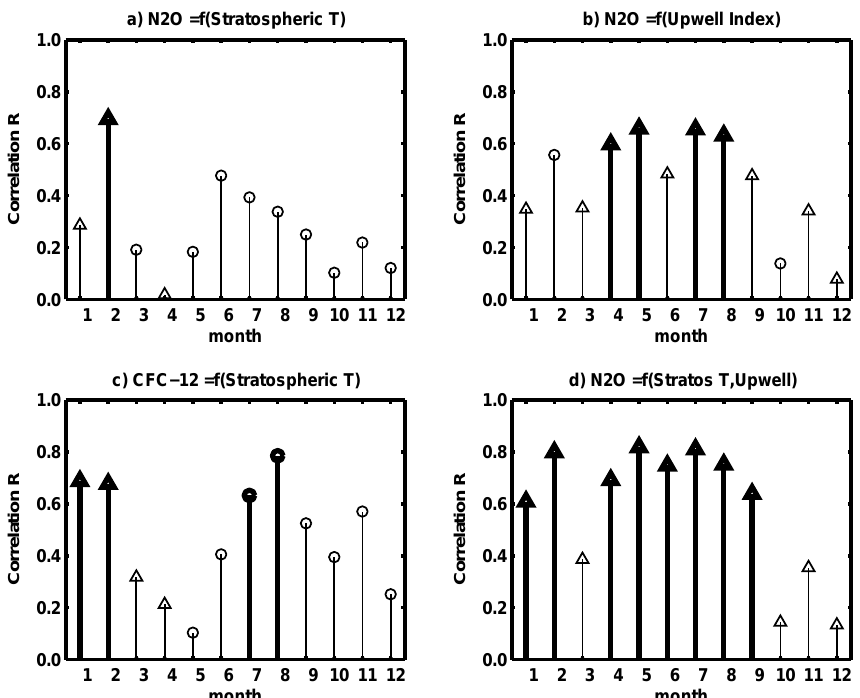
Fig. 8. Stem plots summarizing the linear regression slopes for detrended AGAGE N 2 O or CFC-12 monthly means at Trinidad Head vs. polar winter lower stratospheric temperature and/or the NOAA PFEL upwelling index for the Oregon coast at 45 ◦ N. Heavy black lines indicate statistically significant correlations. Triangles indicate a positive correlation, circles indicate a negative correlation – e.g., in panel (c) , warmer stratospheric temperatures are correlated to more negative CFC-12 values in July–August, i.e., deeper seasonal minima. (a) N 2 O vs. stratospheric temperature, (b) N 2 O vs. upwelling index, (c) CFC-12 vs. stratospheric temperature, (d) multivariate regression of N 2 O vs. stratospheric temperature and upwelling